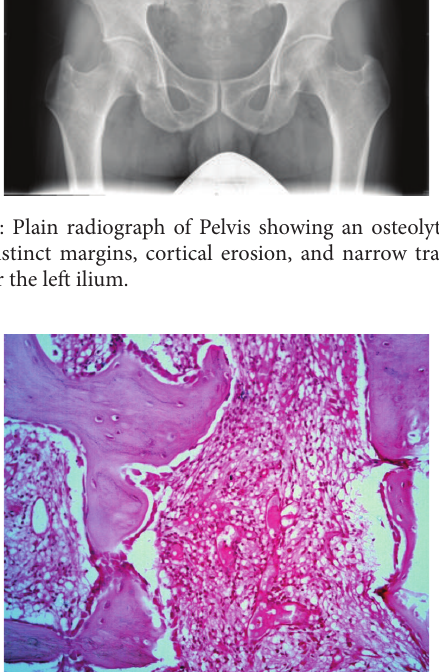
Figure 2: Photomicrograph of chronic osteomyelitis ilium showing trabeculae of cortical, cancellous, and scanty necrotic bone with intervening inflammatory granulation tissue densely infiltrated by lymphocytes and histiocytes (H&E stain, × 20).